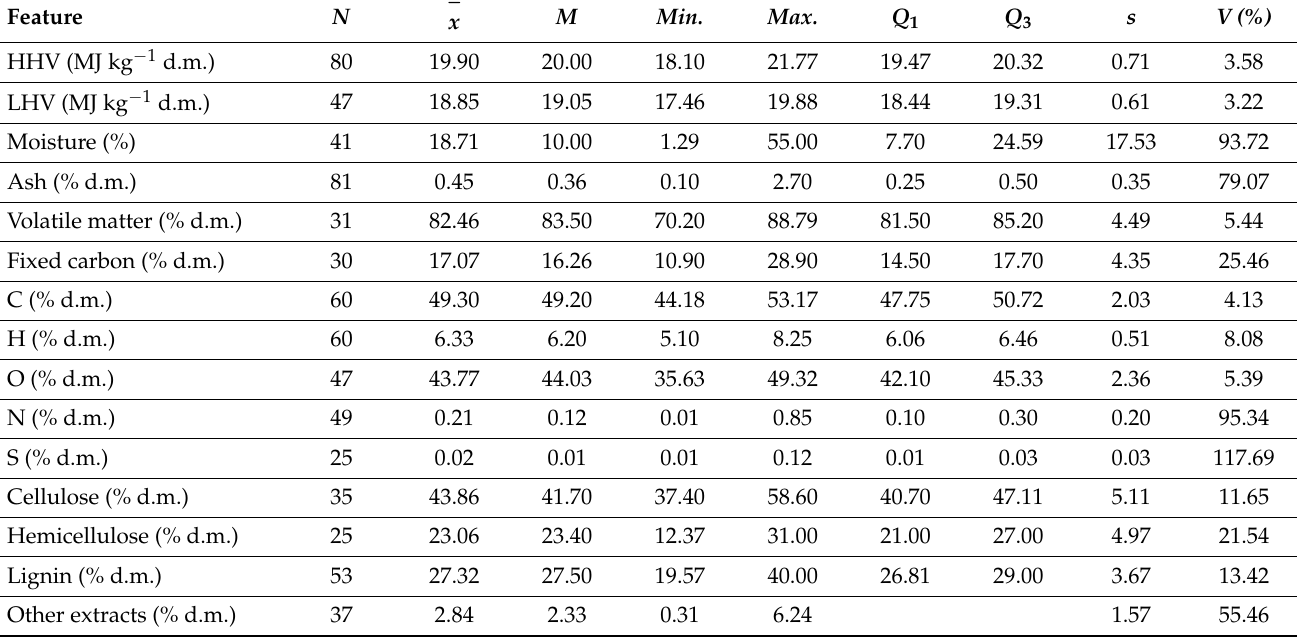
Table 2. Differentiation of the thermophysical properties and composition of coniferous